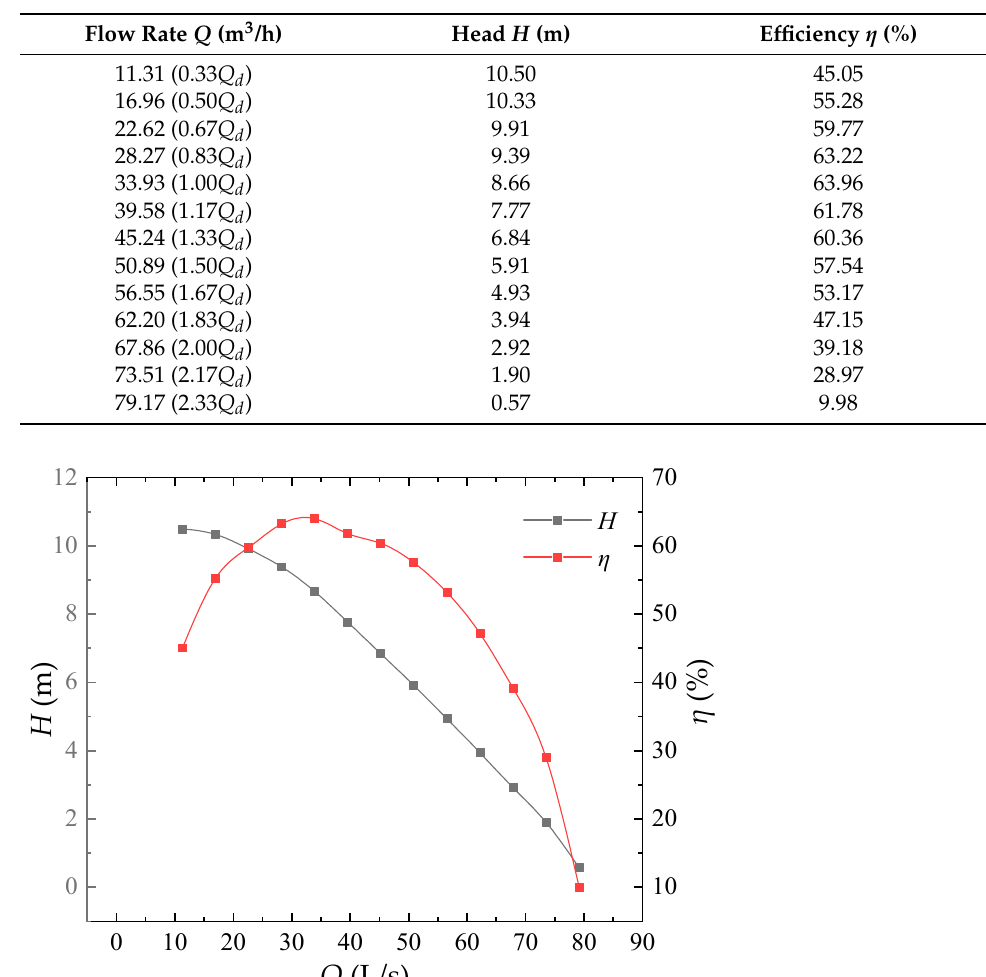
Table 1. Energy characteristics data table.